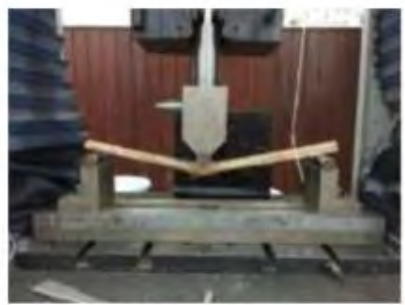
Figure 34. The Bending Procedures in the testing machine for span 400 mm (Author’s own, n.d.)